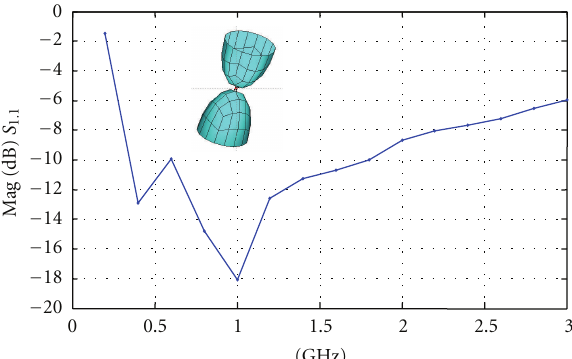
Figure 19: Design and reflection coe ffi cient of an ultra-wideband omnidirectional